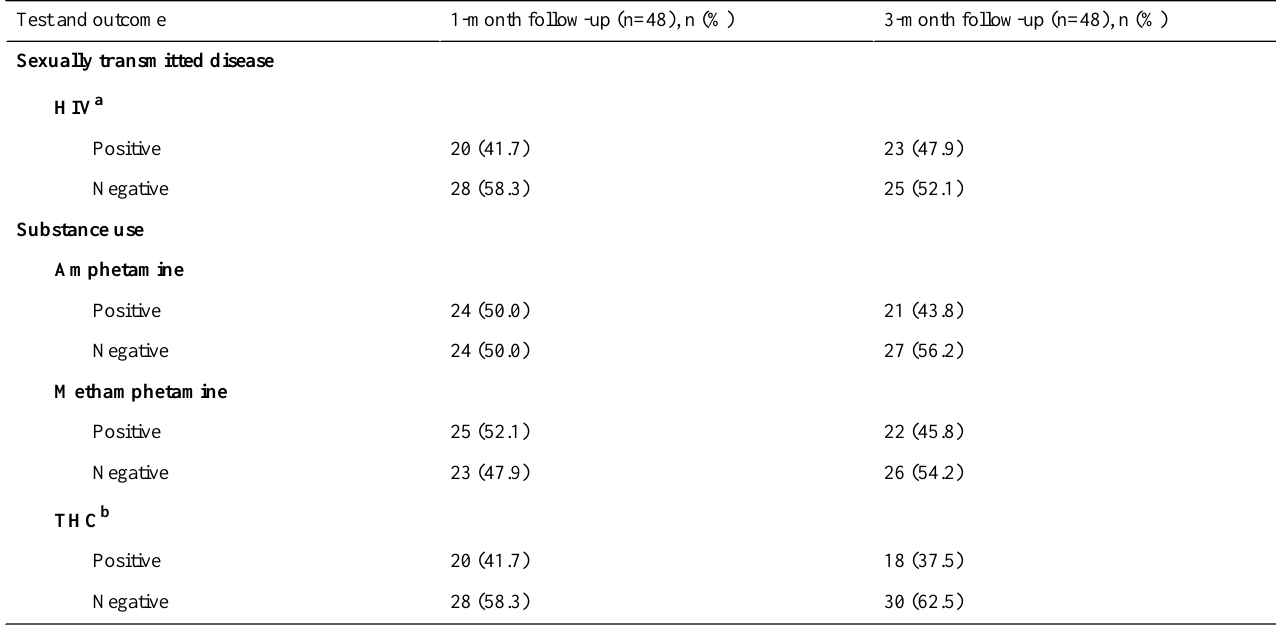
Table 3. Distribution of biomarker outcomes in a 1-month and 3-month follow-up after participants’initial